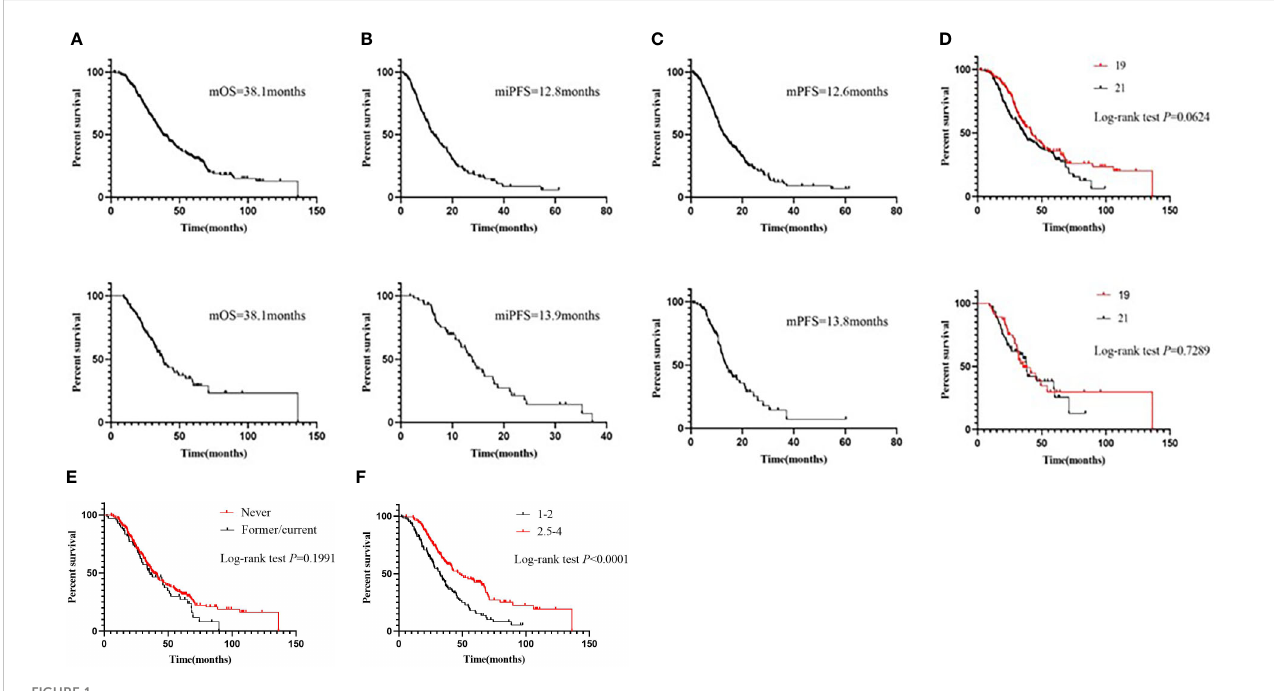
FIGURE 1 Before PSM: (A) Overall survival (OS) of the entire cohort. (B) Intracranial progression-free survival (iPFS) and (C) progression-free survival (PFS) of the entire cohort. OS of patients strati fi ed according to (D) EGFR mutation status.After PSM: (A) Overall survival (OS) of the entire cohort. (B) Intracranial progression-free survival (iPFS) and (C) progression-free survival (PFS) of the entire cohort. OS of patients strati fi ed according to (D) EGFR mutation status. OS of patients strati fi ed according to (E) Smoking status; OS of patients strati fi ed according to (F) Lung-molGPA.